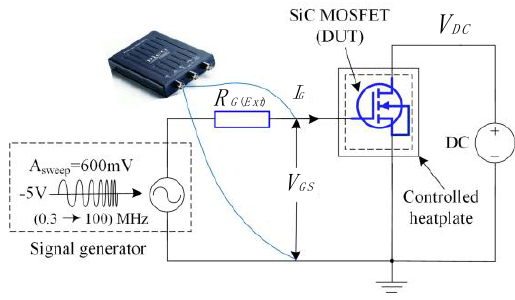
Figure 4. Schematic of the test circuit.